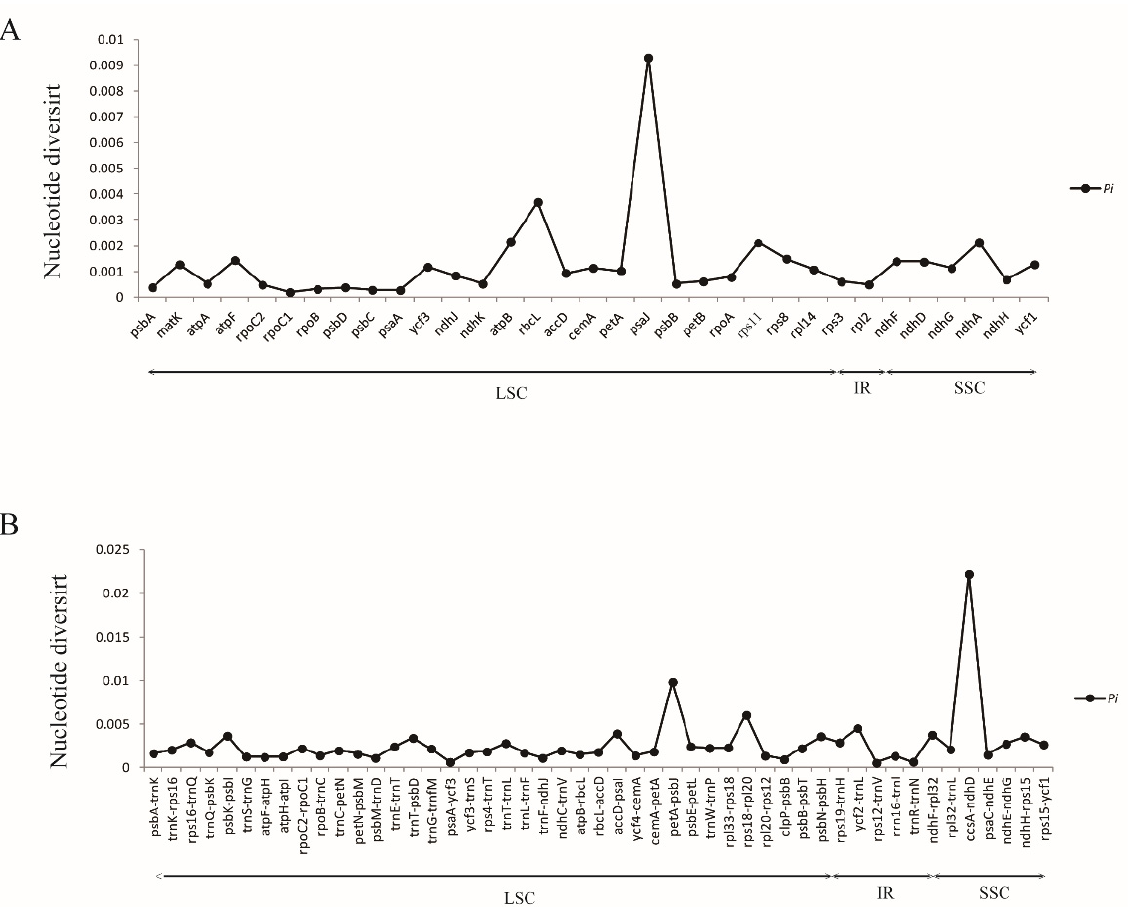
Figure 4. Comparison of nucleotide variability ( Pi ) values in Convallaria plastomes. ( A ) Pi values among protein-coding genes (CDS). ( B ) Pi values among intergenic spacer (IGS) regions.